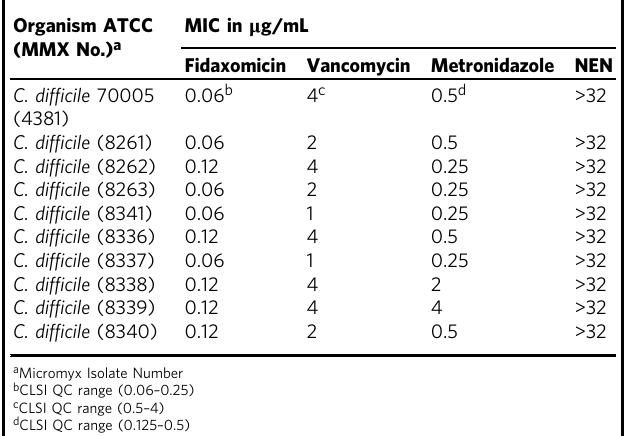
Table 3 C. dif fi cile MIC values for NEN, vancomycin, metronidazole, and fi daxomicin Organism ATCC (MMX No.)